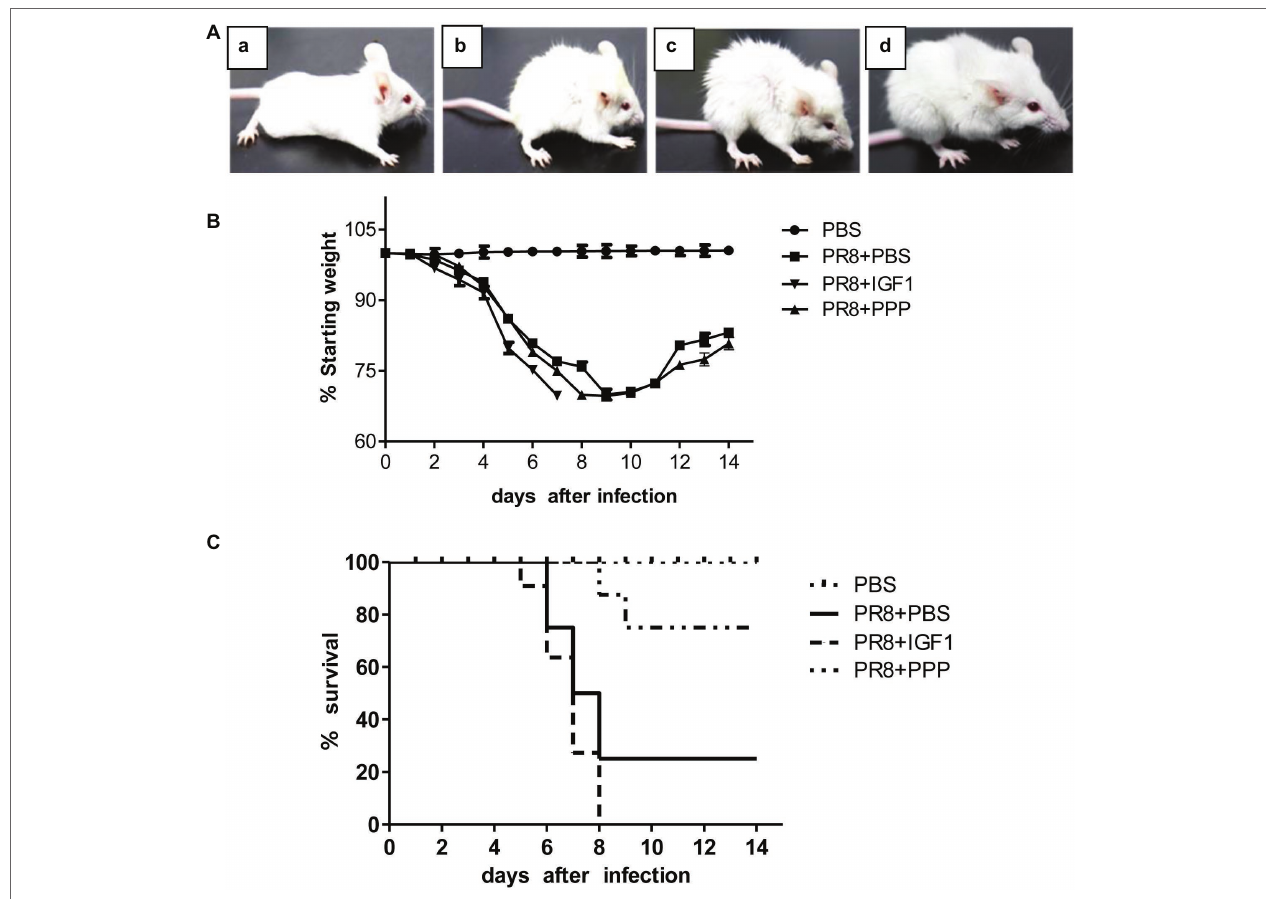
FIGURE 4 | Changes in the clinical manifestations, body weight, and survival rate of BALB/c mice following PR8 infection. (A) Clinical symptoms of BALB/c mice after PR8 infection (50LD 50 ) [ (a) PBS; (b) PR8 + PBS; (c) PR8 + IGF1; (d) PR8 + PPP]; (B) changes in body weight in BALB/c mice after PR8 infection (50LD 50 ); and (C) survival rate of BALB/c mice after PR8 infection (50LD 50 ; n =